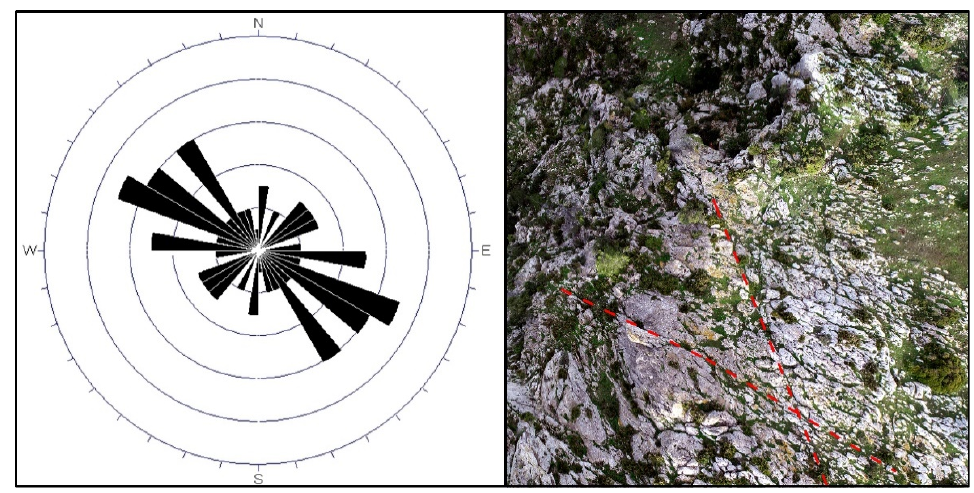
Figure 4. Major joint directions obtained from the field investigations and UAV images.